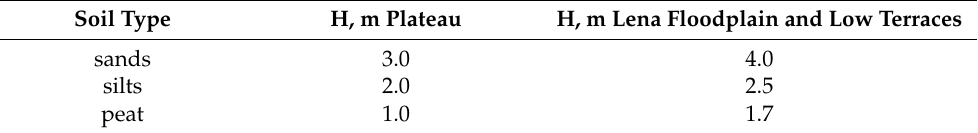
Table 2. Active-layer thicknesses (H,